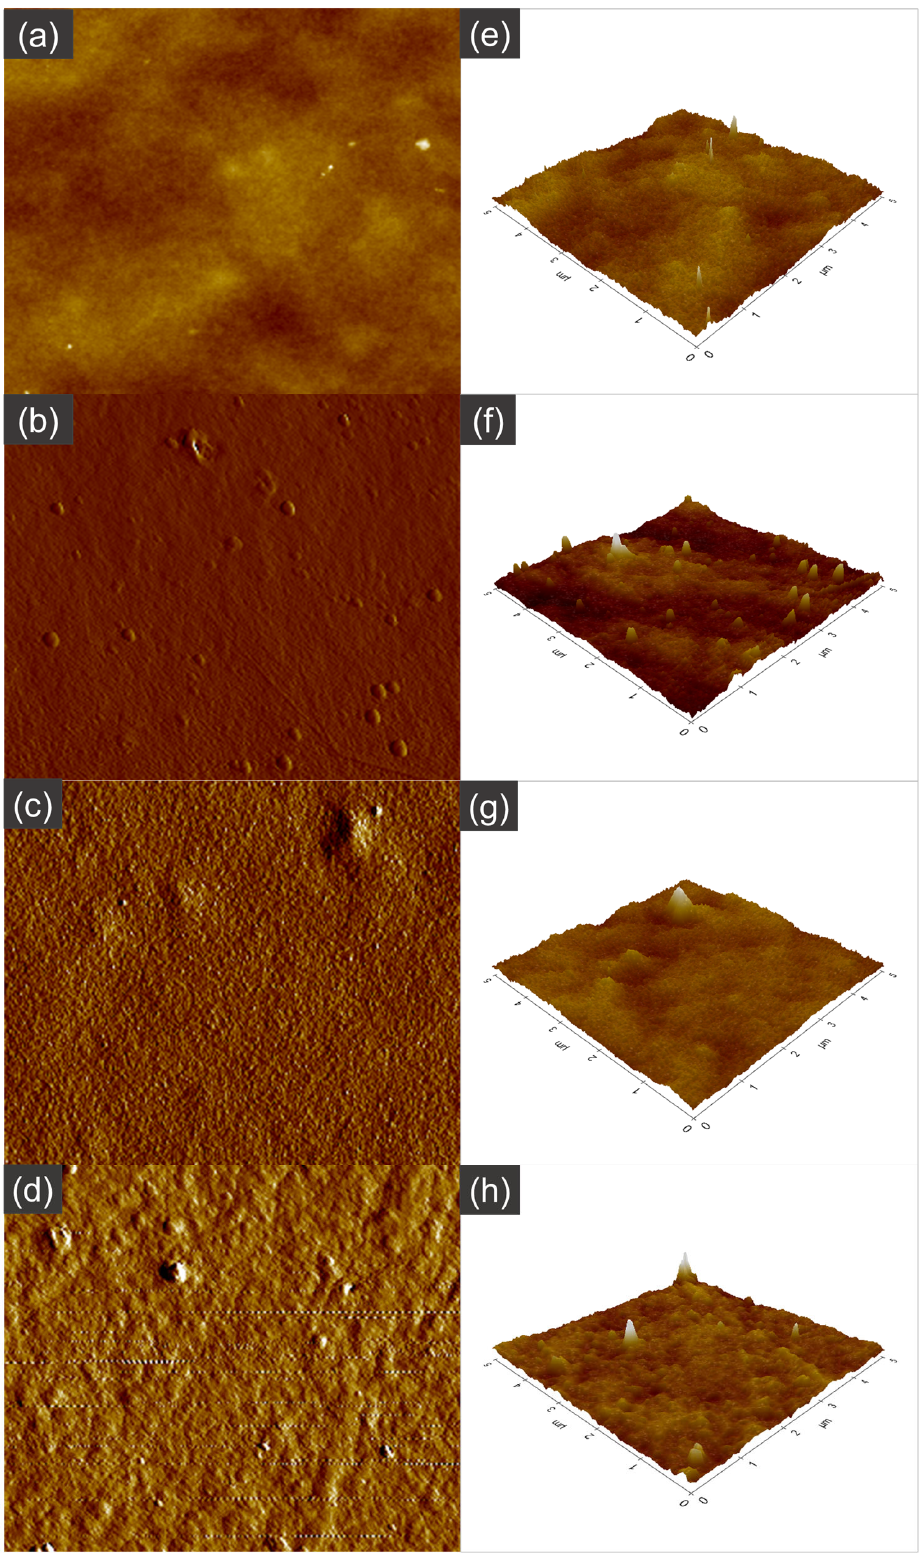
Figure 8. AFM images (5 μ m × 5 μ m) of the top surface of the NF2 PES membrane ( a , e ) and UV − grafted membranes 0.1 MAA3 ( b , f ), 0.5 MAA3 ( c , g ) and 1.0 MAA3 ( d , h ).